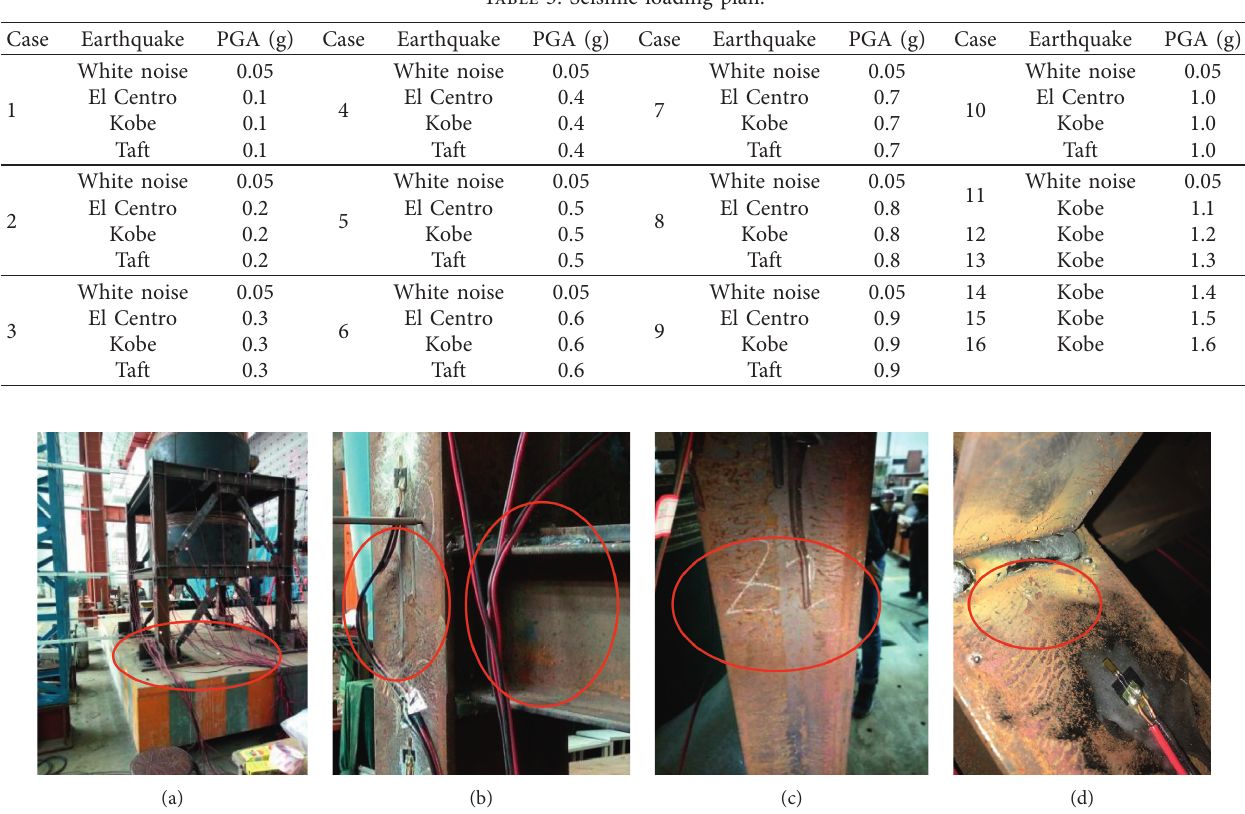
Table 3: Seismic loading plan.